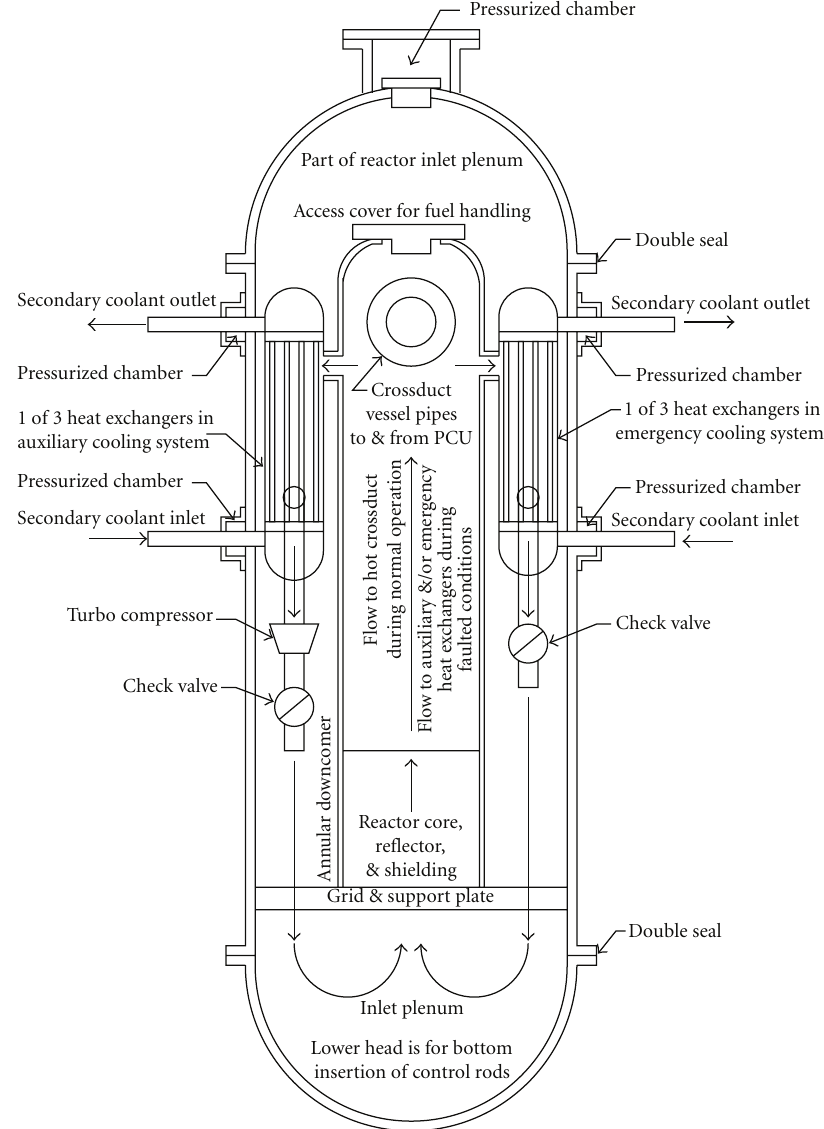
Figure 15: Reactor vessel layout for natural convection or autonomous system in direct-cycle